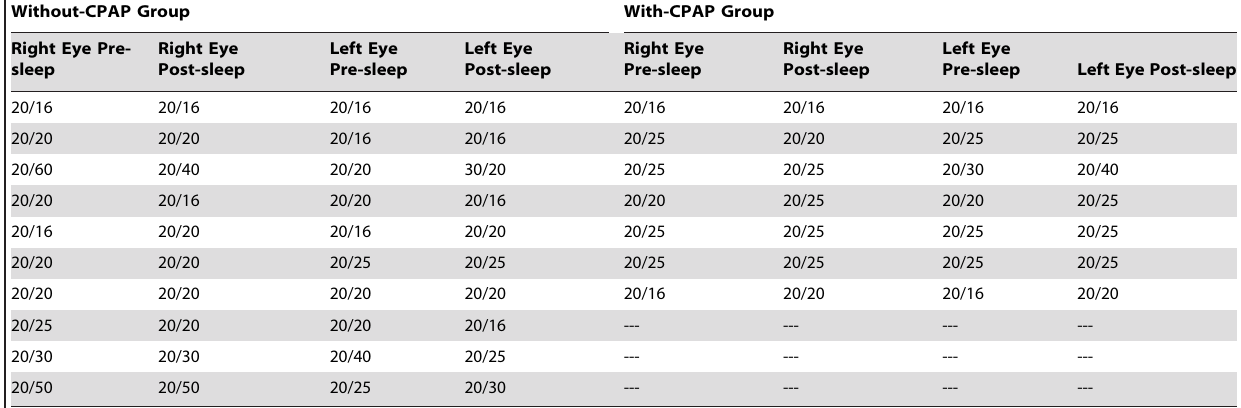
Table 3. Visual acuity values of each